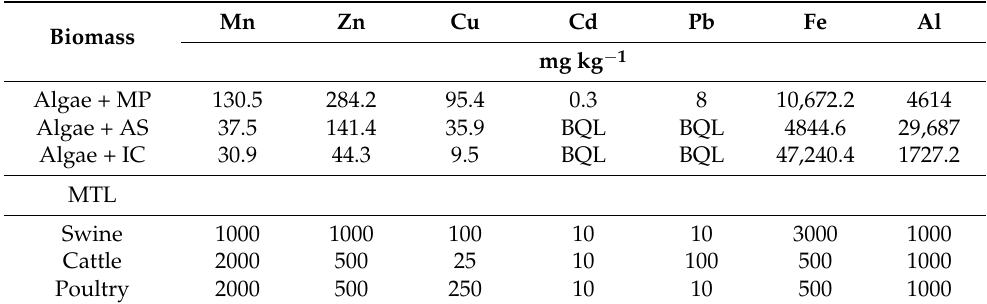
BQL—below quantification